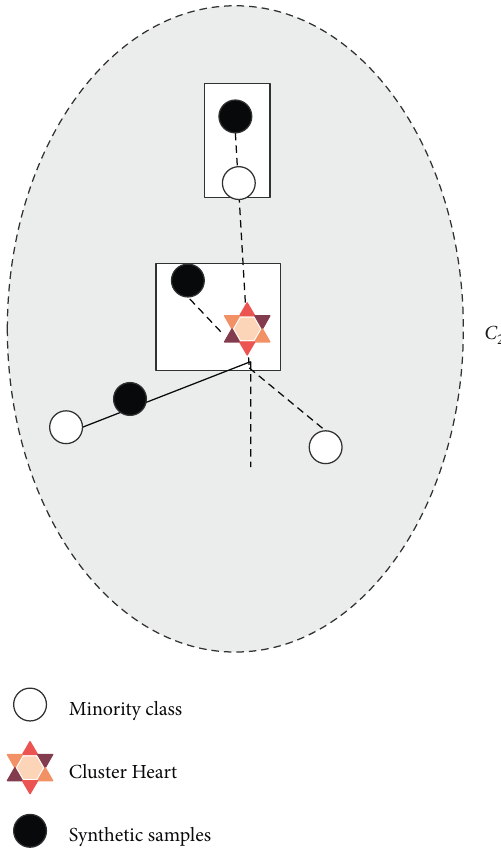
Figure 2: KM-SMOTE oversampling samples.